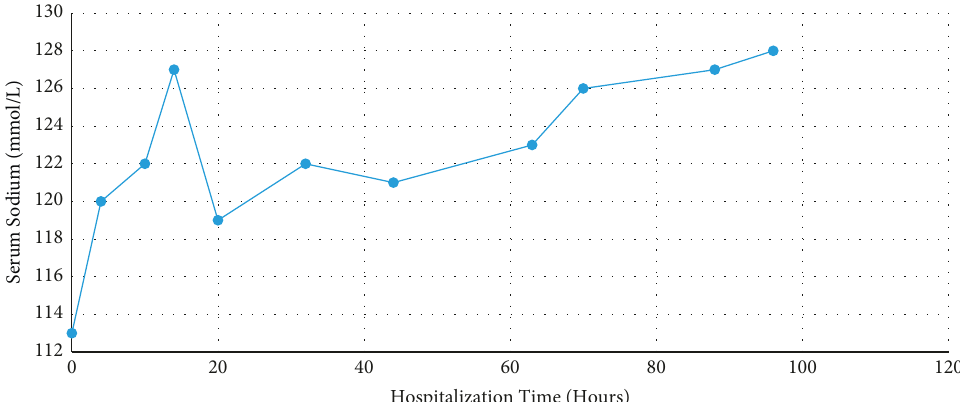
Figure 1: The Patient’s sodium level throughout his hospital stay. He presented initially with a sodium level of 113mmol/L at hour 0, then corrected to 127mmol/L after receiving 2 liters of normal saline, which prompted a nephrology consult. The patient then received D5W and DDAVP, and sodium was able to lower to 119mmol/L at hour